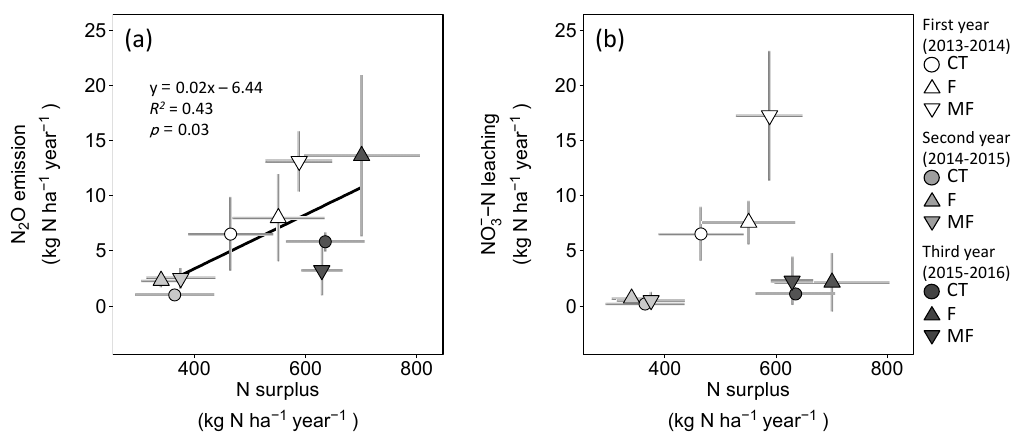
Figure 3. Relationship between annual N 2 O emission ( a ), annual NO 3 − –N leaching ( b ) and nitrogen surplus (N surplus). CT is unfertilized control plots ( ○ ); F is chemical fertilizer plots ( △ ); MF is combined manure and chemical fertilizer plots ( ▽ ). Error bar represents standard deviation. The black solid line indicates a simple linear regression model.